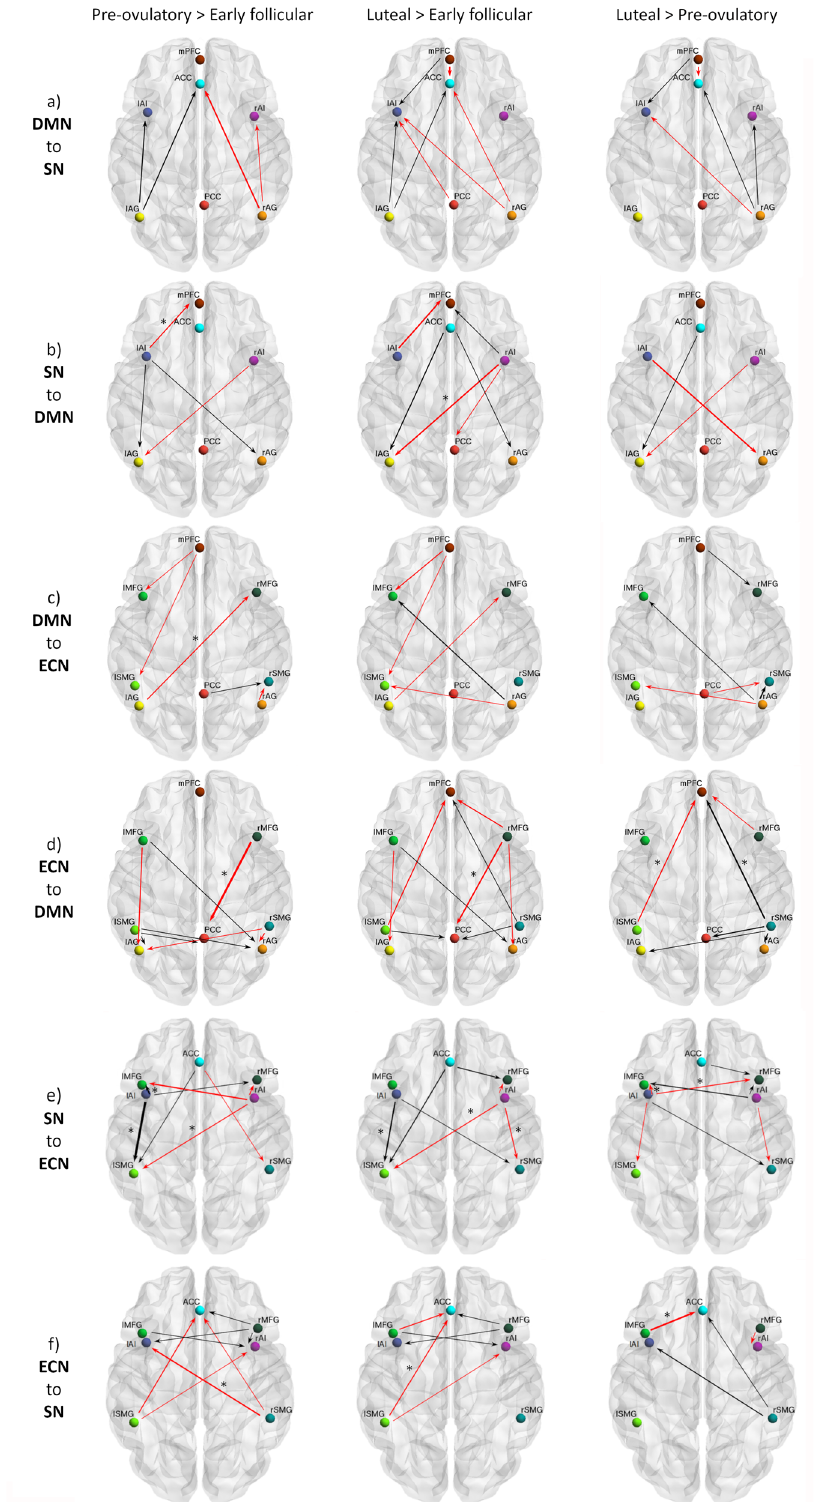
Fig. 3 Cycle phase differences in between-network effective connectivity. a From the DMN to the SN; b From the SN to the DMN; c From the DMN to the ECN; d From the ECN to the DMN; e From the SN to the ECN; f From the ECN to the SN. Only connections with a posterior probability >0.75 are displayed. Connections surpassing a posterior probability of 95% are indicated with an asterisk. The results re fl ect connection strengths as a difference between the indicated cycle phases. The differential connection strengths are depicted by the width of the arrow. Black arrows re fl ect positive values and red arrows re fl ect negative values for those connections which showed differences in the former than in the latter indicated cycle